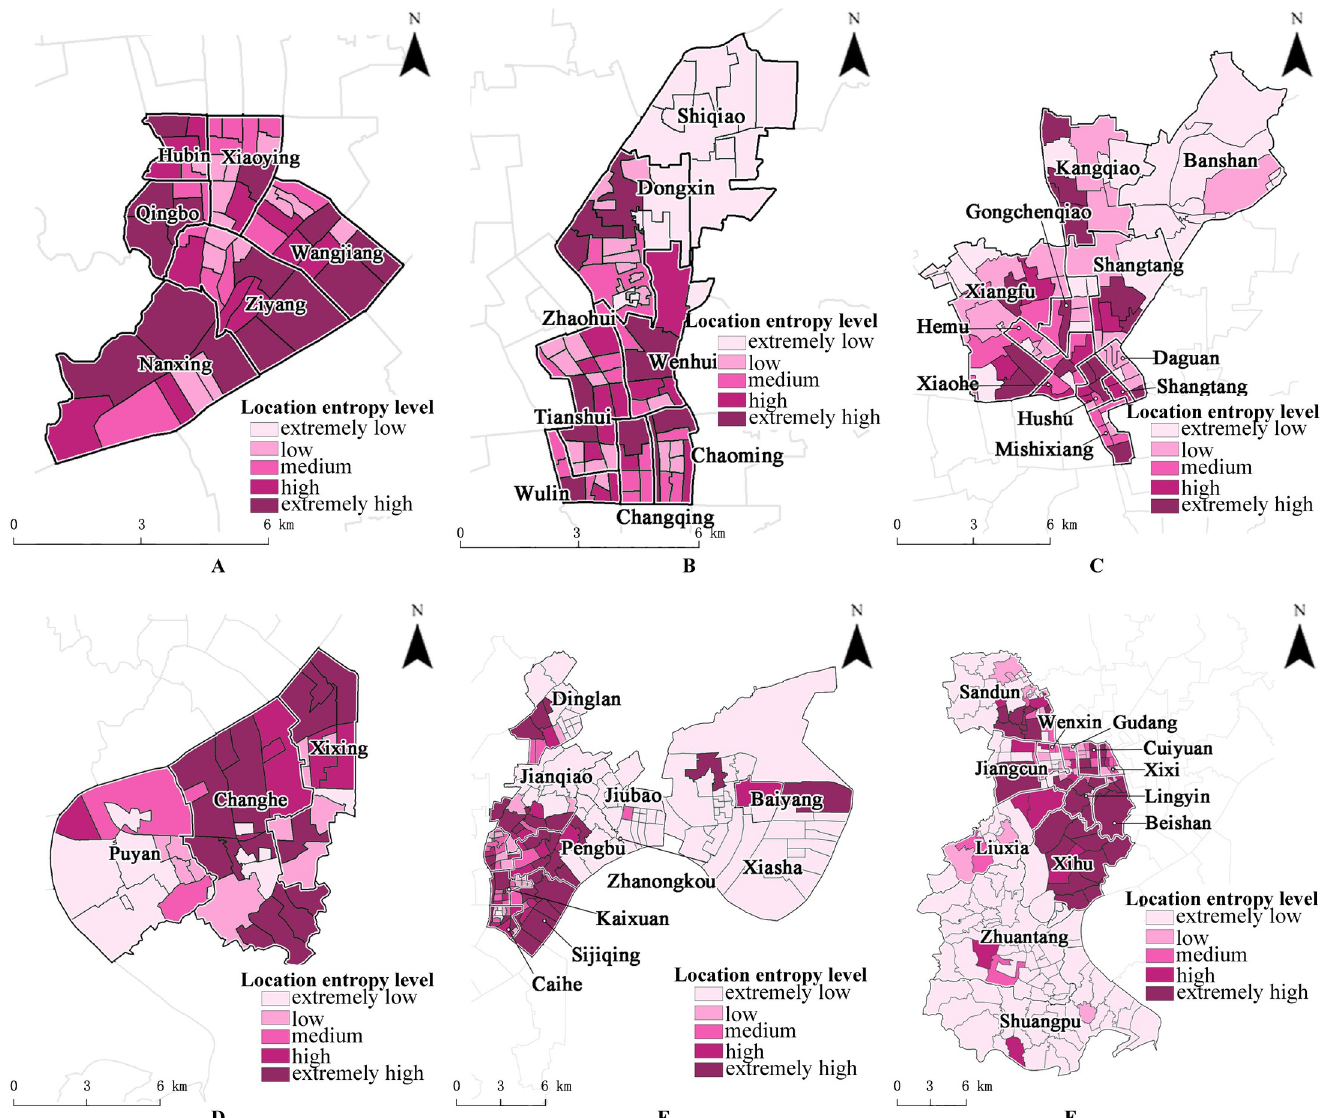
Fig 8. Distribution pattern of location entropy in each district. (A) Distribution pattern of location entropy in Shangcheng District; (B) Distribution pattern of location entropy in Xiacheng district; (C) Distribution pattern of location entropy in Gongshu District; (D) Distribution pattern of location entropy in Bingjing District; (E) Distribution pattern of location entropy in Jianggan District; (f) Distribution pattern of location entropy in Xihu District. Source: Created by the author based on the base map of Hangzhou which comes from the National Platform for Common Geospatial Information Services (https://www.tianditu.gov.cn/).